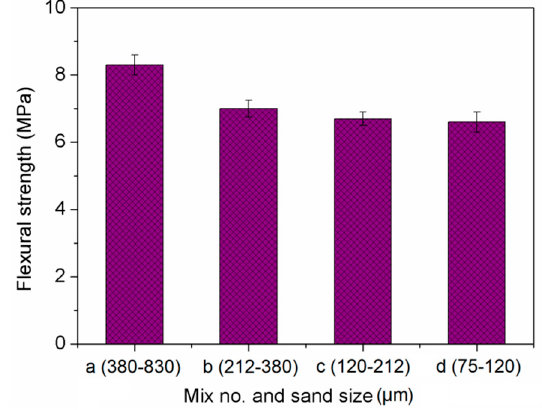
Figure 7. Flexural strength of cement-based Figure 7 . Flexural strength of cement-based composites.